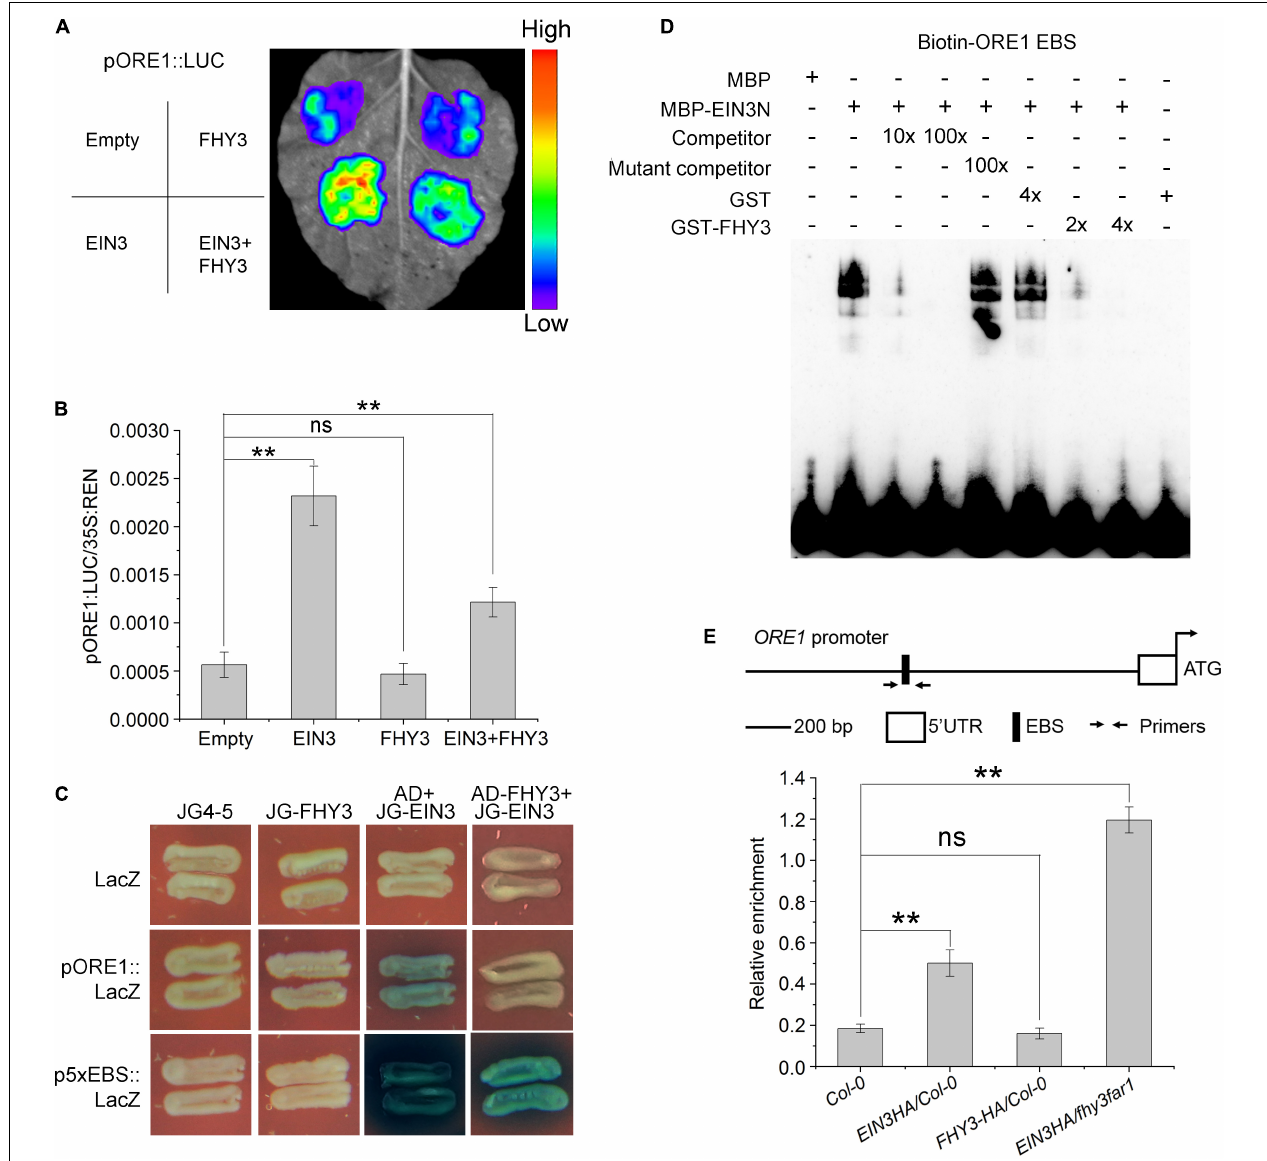
FIGURE 4 | FHY3 repress the DNA binding activity of EIN3. (A) Transient expression assay shows that the addition of FHY3 leads to down-regulation of the ORE1 expression. (B) Dual-luciferase assay of LUC expression in (A) . The expression of REN was used as an internal control. LUC/REN ration represents the relative activity of the promoters. Values are means ± SD ( n = 3). Significant difference was identified with Student’s t -test. ns, no significance; ** p < 0.05. The pSPYNE-35S and pCAMBIA1307 empty vectors were used as controls. (C) Yeast one-hybrid assay shows that EIN3 binds to the ORE1 promoter through the EIN3-binding site (EBS) and FHY3 partially disrupted the interaction between EIN3 and the ORE1 promoter. 5x EBS, 5 repeats of the EBS in the ORE1 promoter. (D) EMSA results show that FHY3 affects the binding of EIN3 (EIN3N, aa 141–352) to the ORE1 promoter. Different concentration of GST-FHY3 protein (aa 186–839) was applied (4 µ g for lane 7, 8 µ g for lane 8). Eight µ g of GST was added to lane 6 as a negative control. (E) ChIP-qPCR shows the in vivo binding of EIN3 to EBS in the ORE1 promoter. Cross-linked chromatins from EIN3-HA were precipitated with anti-HA antibodies. Eluted DNA was subjected to amplification of the neighboring sequences of EBS by qRT-PCR. Col-0 and FHY3-HA plants were used as negative controls. Error bars represent SD ( n = 3). Significant difference was identified with Student’s t -test. ns, no significance; ** p <